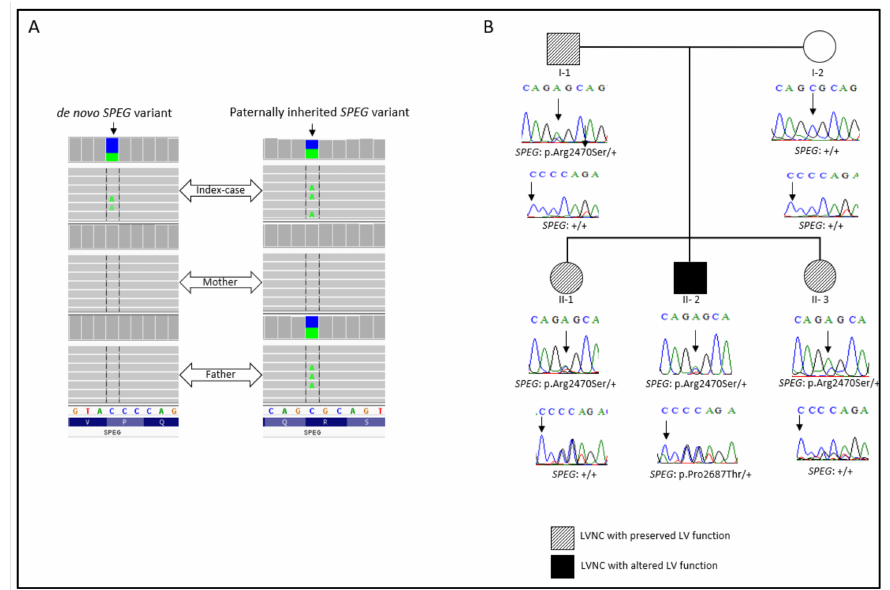
Figure 2. ( A ) Integrative genomics viewer visualization showing the de novo and the inherited SPEG variants. ( B ) Family pedigree. Sanger electropherograms and genotypes are shown below symbols: (+) indicates the wild-type allele, and the arrow indicates the position of the